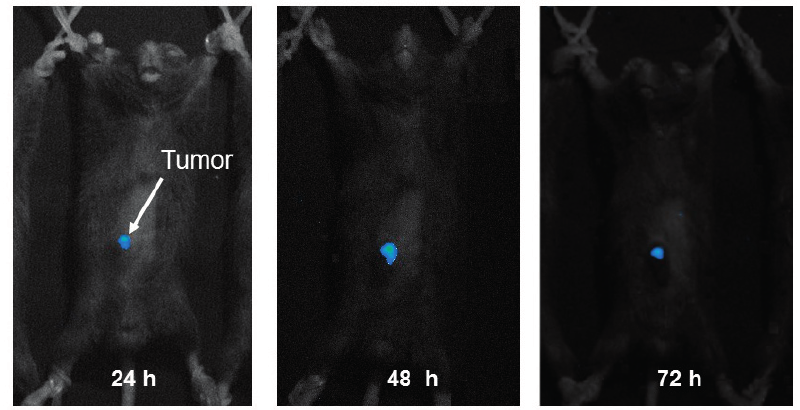
Figure 8. In vivo imaging of the tumor-bearing mouse injected with 200 μ g of DNA(luciferase)/(PEI “Max”)/CS complexes (1:12:8).